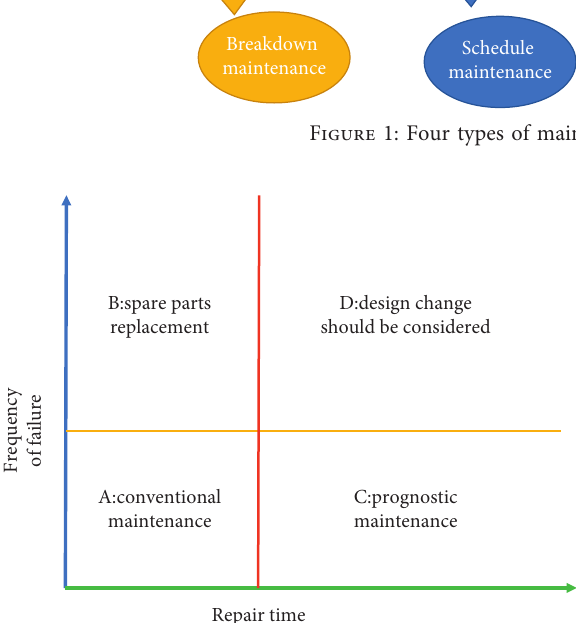
Figure 2: Selection of mechanical component maintenance